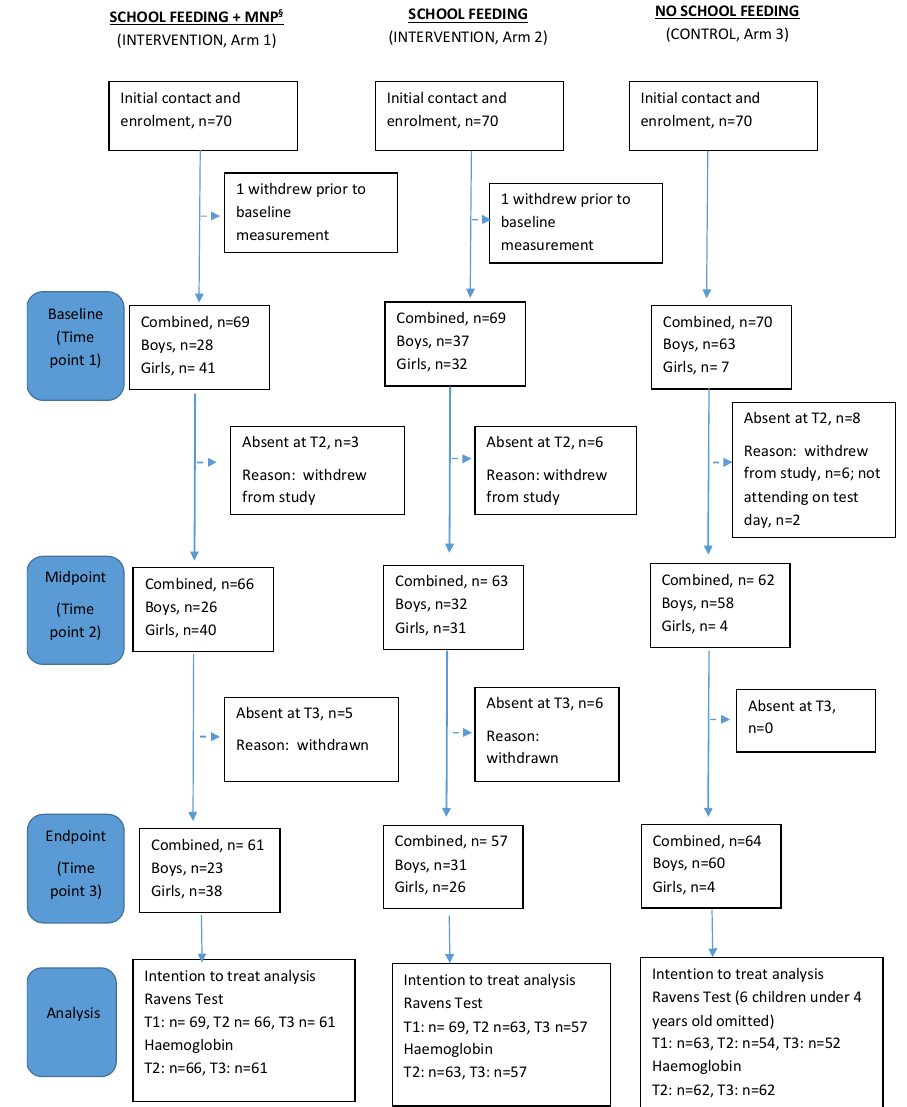
Figure 2. Participant flow diagram showing participant withdrawals at each time point. § Micronu- trient powder.